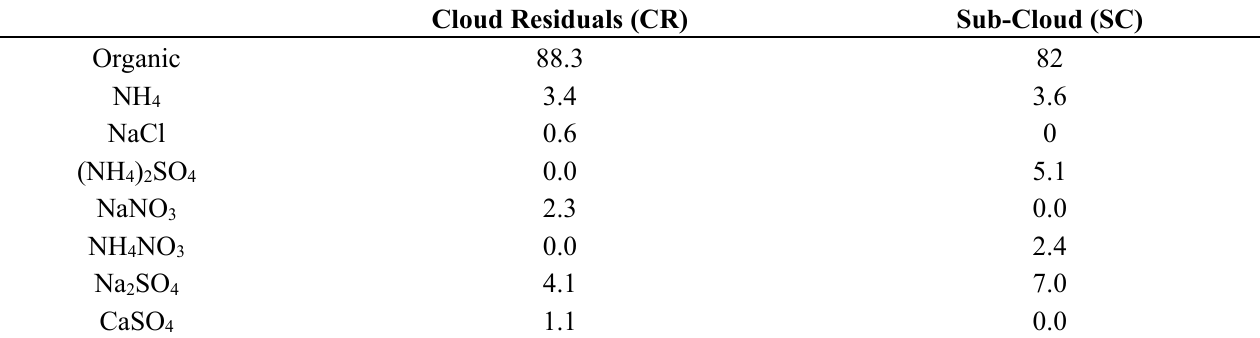
Table 2. Mass fraction (%) of constituents in the aerosol samples considered in this study. equilibrium model (ISORROPIA-II), using the ionic composition of Table